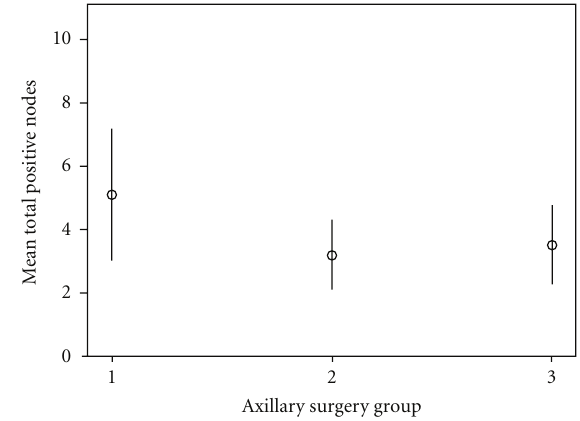
Figure 2: Mean number of positive nodes harvested in the three cohorts ( ± 95% confidence interval). Group classification of pa- tients by axillary procedure: group 1: primary axillary clearance; group 2: SLNB and dALND; group 3: SLNB and